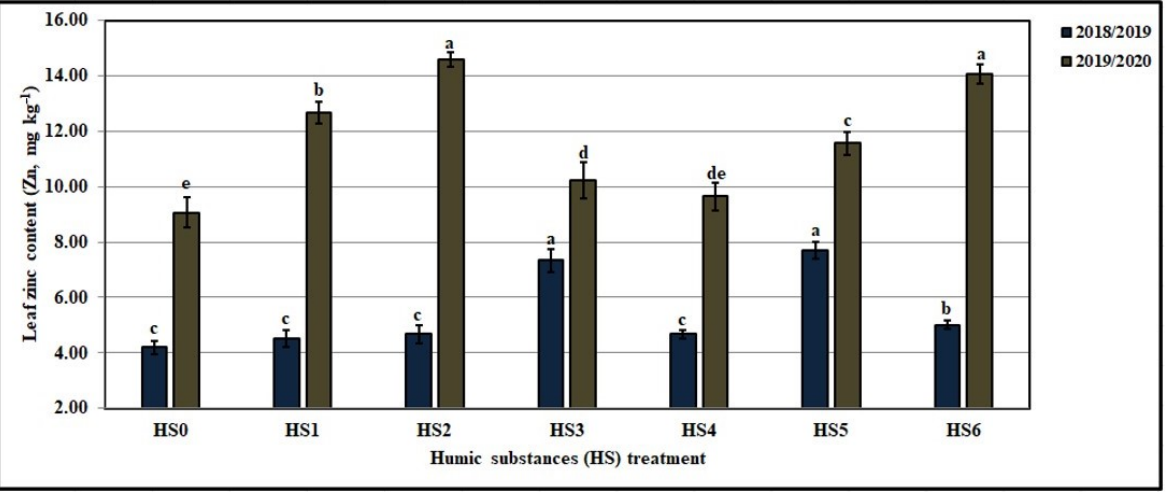
Figure 27. Influence of humic substances treatments on leaf zinc contents (Zn, mg kg − 1 ) of some wheat varieties grown in clay loam soil in 2018/2019 and 2019/2020 seasons. Bars in the same years with a different letter indicate significant differences between treatments at p ≤ 0.01. HS 1, HS 2 , HS 3 represent HS applied as foliar spray at 1.0, 2.0, 4.0 g L − 1 , respectively, HS 4 , HS 5 , HS 6 represent HS applied as soil application at 5.04, 7.56, 10.08 kg ha − 1 .